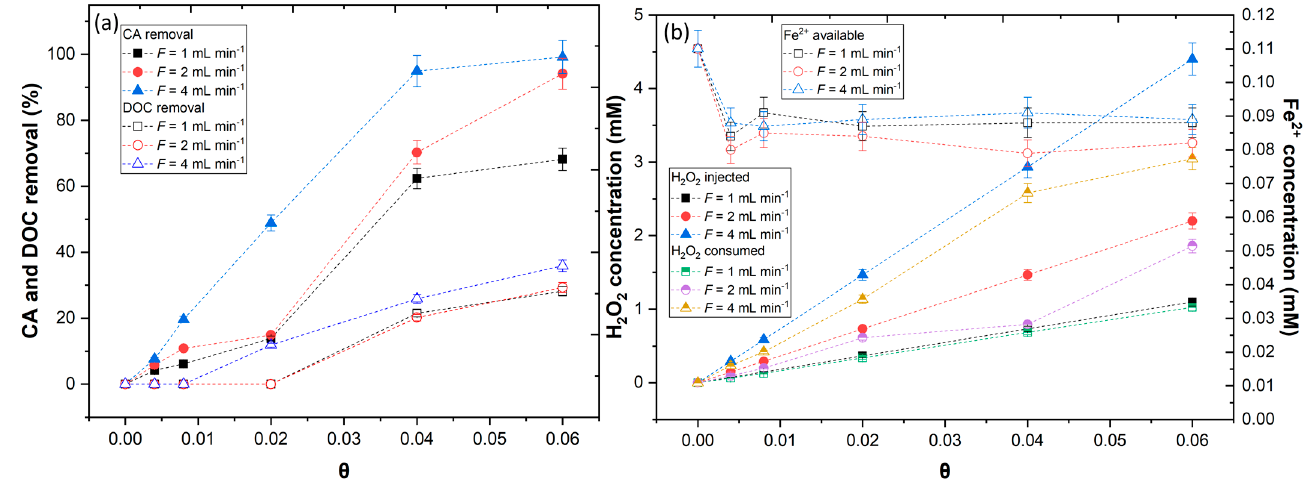
Figure 8. Assessment of different flow rates (1–4 mL min − 1 ) in ( a ) CA and DOC removal; ( b ) H 2 O 2 and Fe 2+ concentration available as function of θ . Operational conditions: [CA] = 5.5 × 10 − 4 mol L − 1 , [Fe 2+ ] = 1.1 × 10 − 4 mol L − 1 , pH = 3.0, agitation 150 rpm, temperature = 298 K, radiation UV-A, I UV = 32.7 W m − 2 , HRT = 15 min.